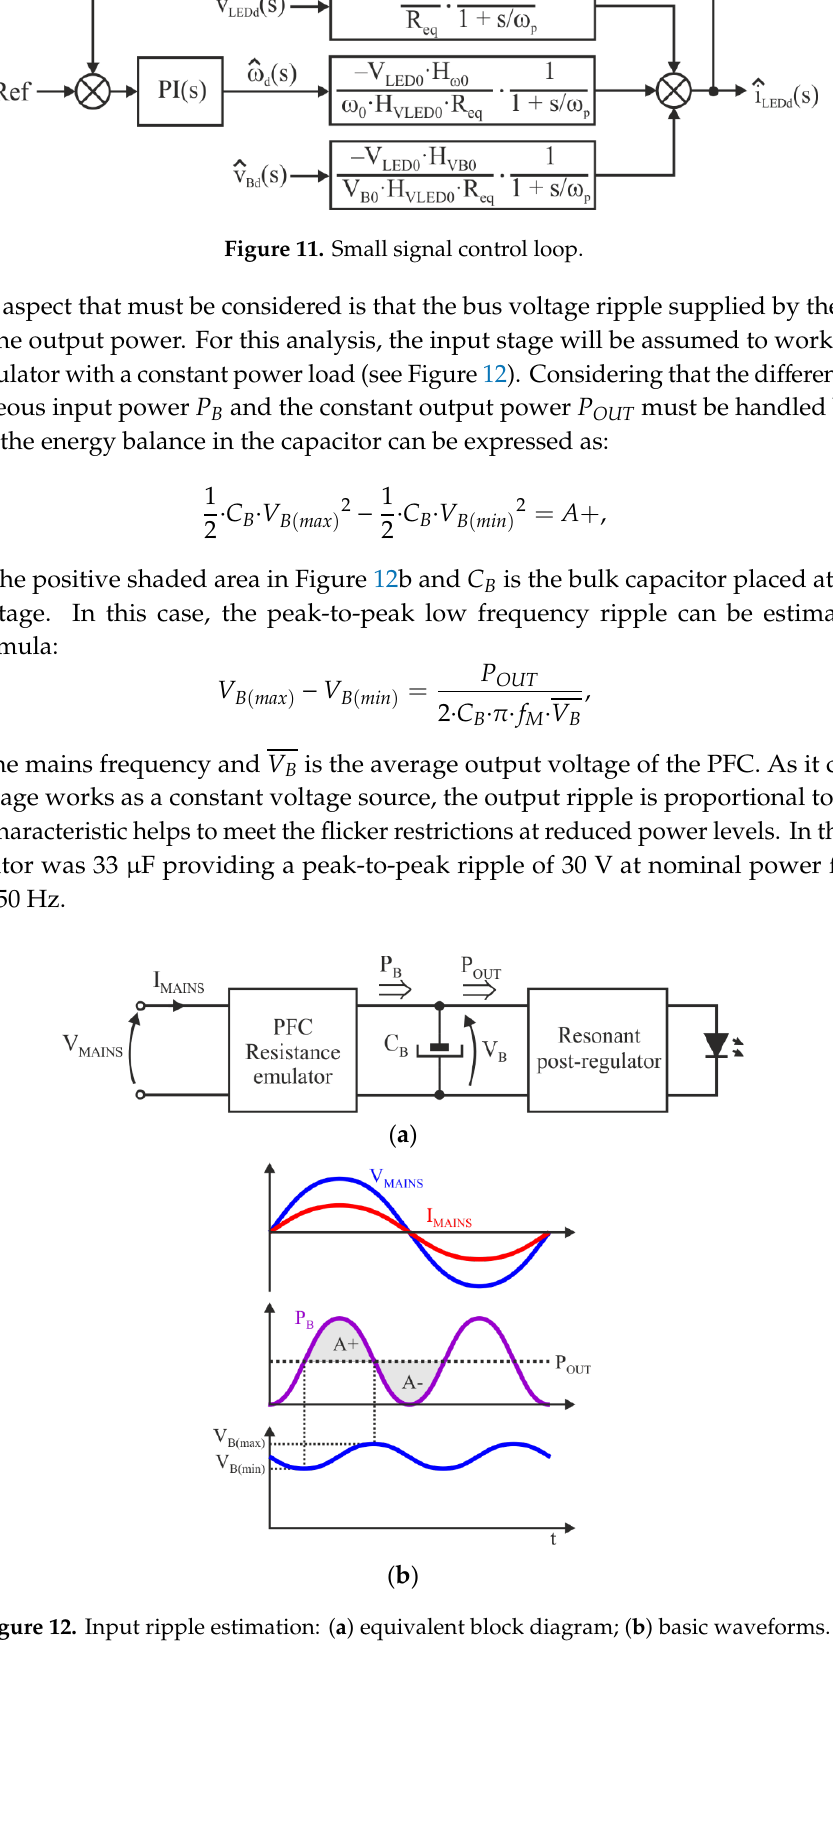
Figure 10. System pole frequency as a function of the operating frequency.